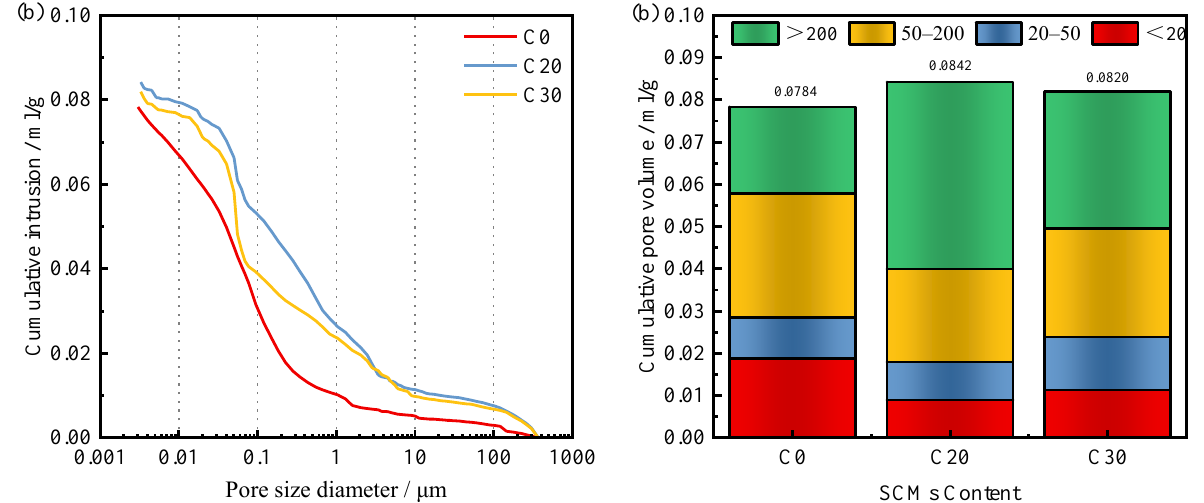
Figure 10. The influence of SCMs content on the ( a ) cumulative intrusion volume, and ( b ) pore volume distributions of the 28-d concrete.